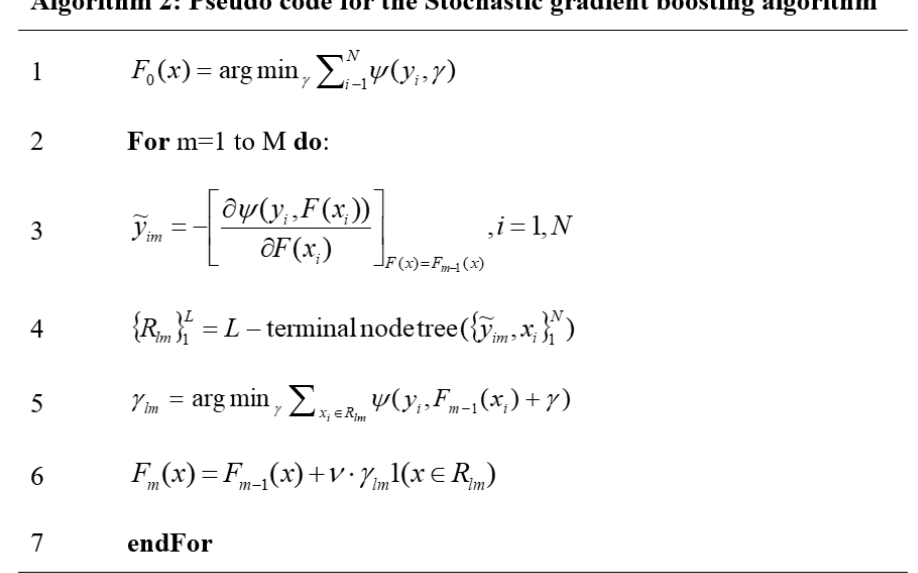
Figure 2. Pseudo-code of the stochastic gradient boosting (SGB) technique. Reproduced with permission from [41], Copyright Elsevier, 2002.